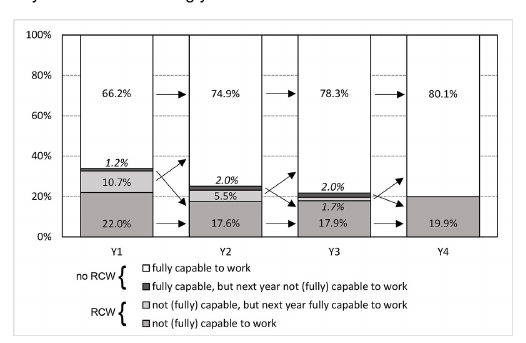
Figure 2: Change in capacity to work after 1 to 4 years. Arrows in- dicate case changes between subgroups: By definition, the two central groups (coloured black and light grey) include all patients with a changing capability to work between single years, i.e. being capable or not (fully) capable to work in the according year, but not anymore in the following year